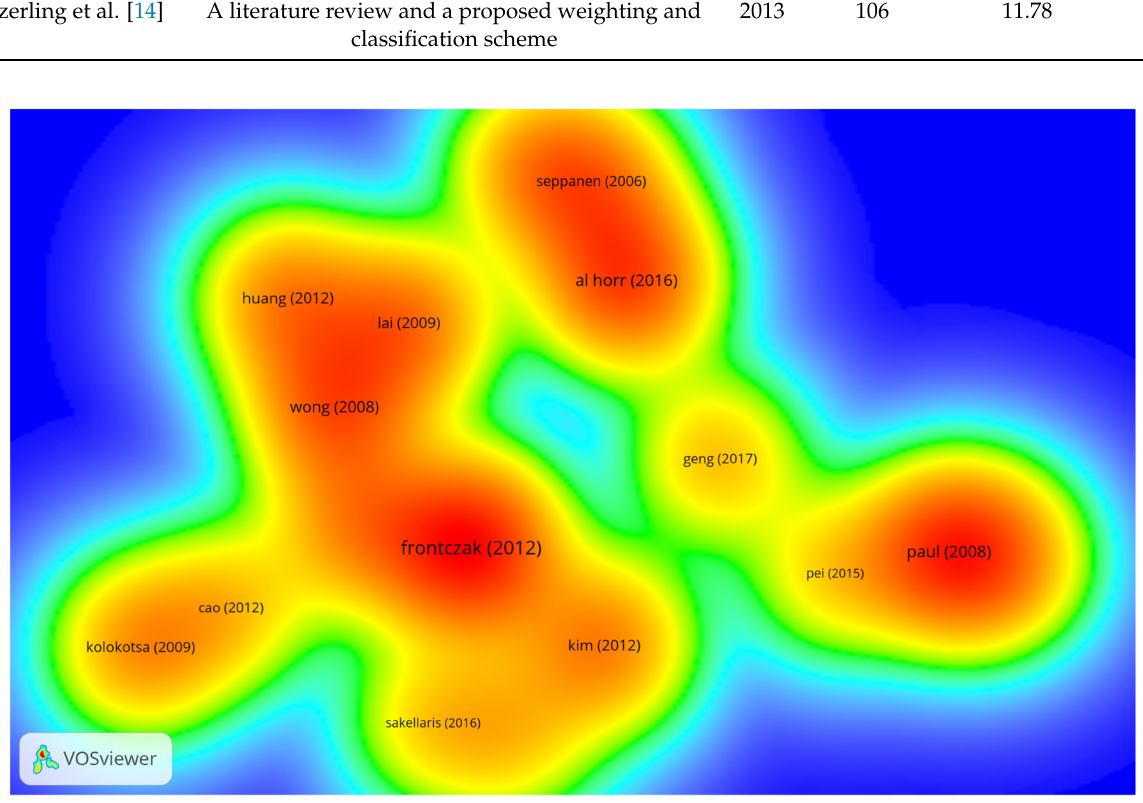
Figure 9. Prominent publications in the IEQMI